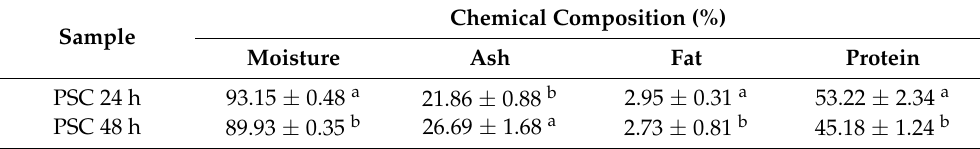
Table 2. Chemical composition of pepsin soluble collagen (PSC) 24 h and 48 h extraction time.